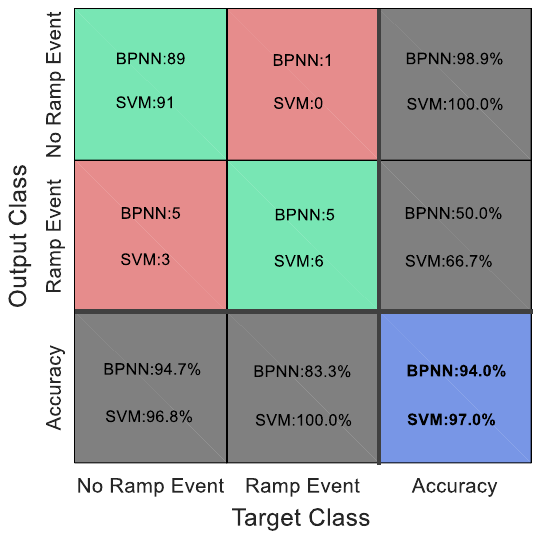
Figure 14. Confusion matrix of the prediction results in the No. 1 wind farm.